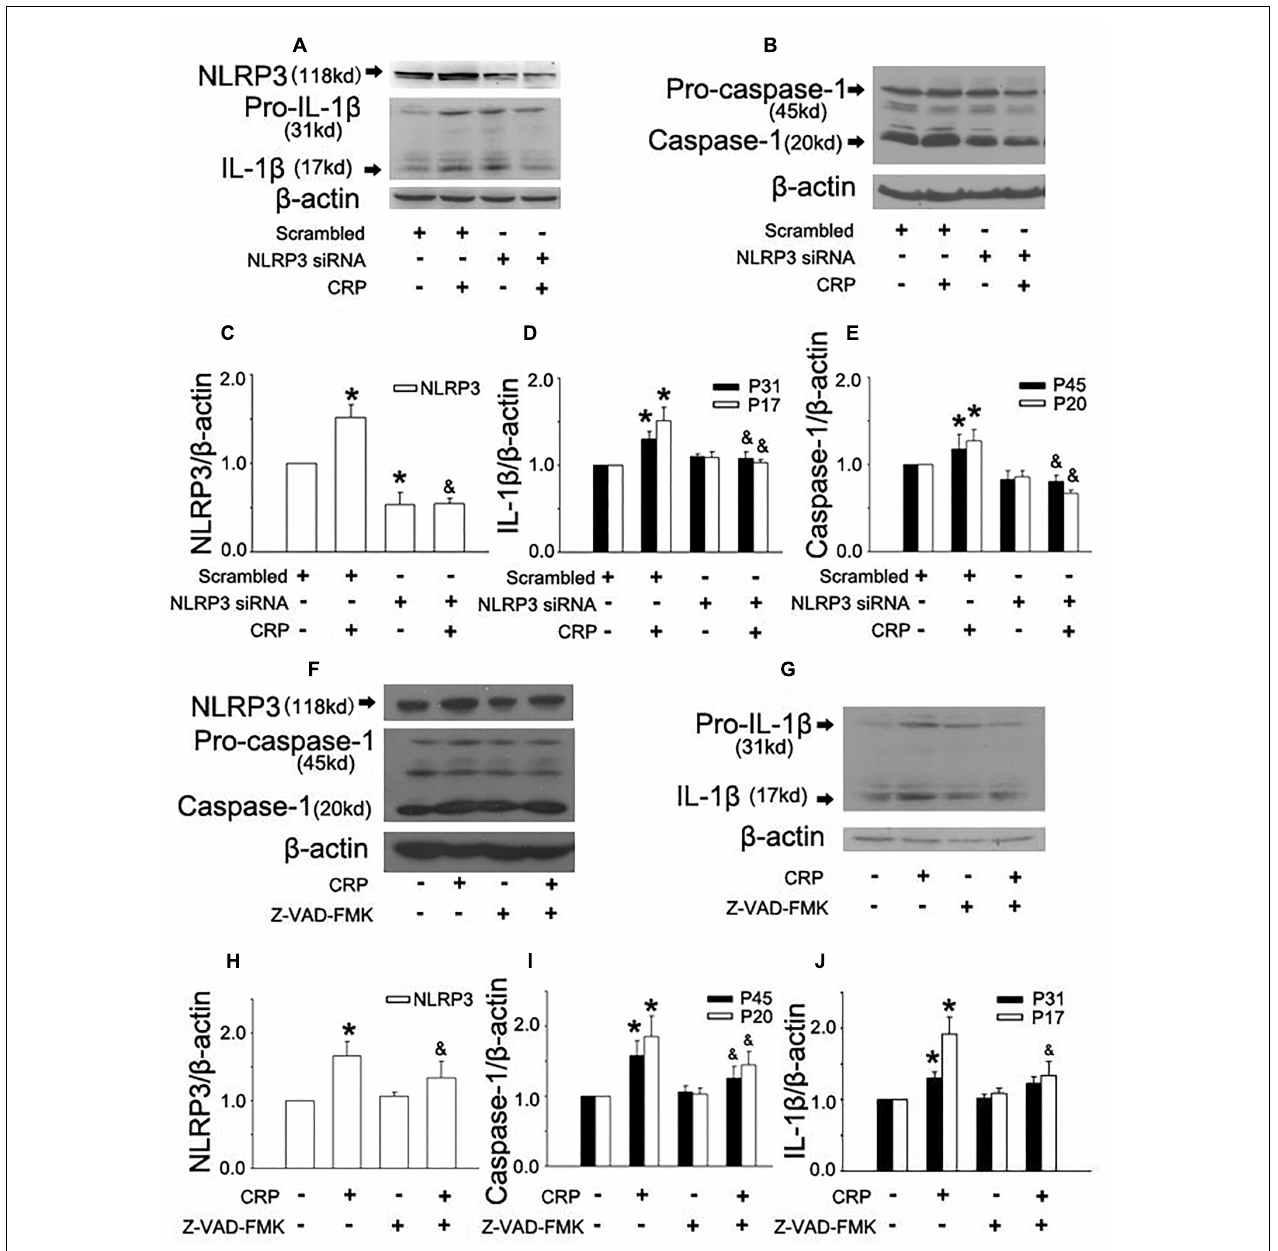
FIGURE 1 | Effect of C-reactive protein (CRP) on NLRP3 inflammasome activation. HUVECs were transfected with 20 µ mol/L NLRP3 siRNA, 20 µ mol/L Scrarmbled siRNA for 24 h (A–E) or incubated with 20 µ mol/L Z-VAD-FMK for 1 h (F–J) , and then were treated in the absence or presence of 20 µ g/mL CRP for 24 h. (A , B , F , G) Representative western blots showing the expression of NLRP3, pro-caspase-1, caspase-1, pro-IL-1 β , and IL-1 β . (C–E , H–J) Summary bar graphs showing the expression of proteins. ∗ P < 0.05 vs. Scrambled siRNA or Ctr; & P < 0.05 vs. Scrambled siRNA+CRP or CRP; n =